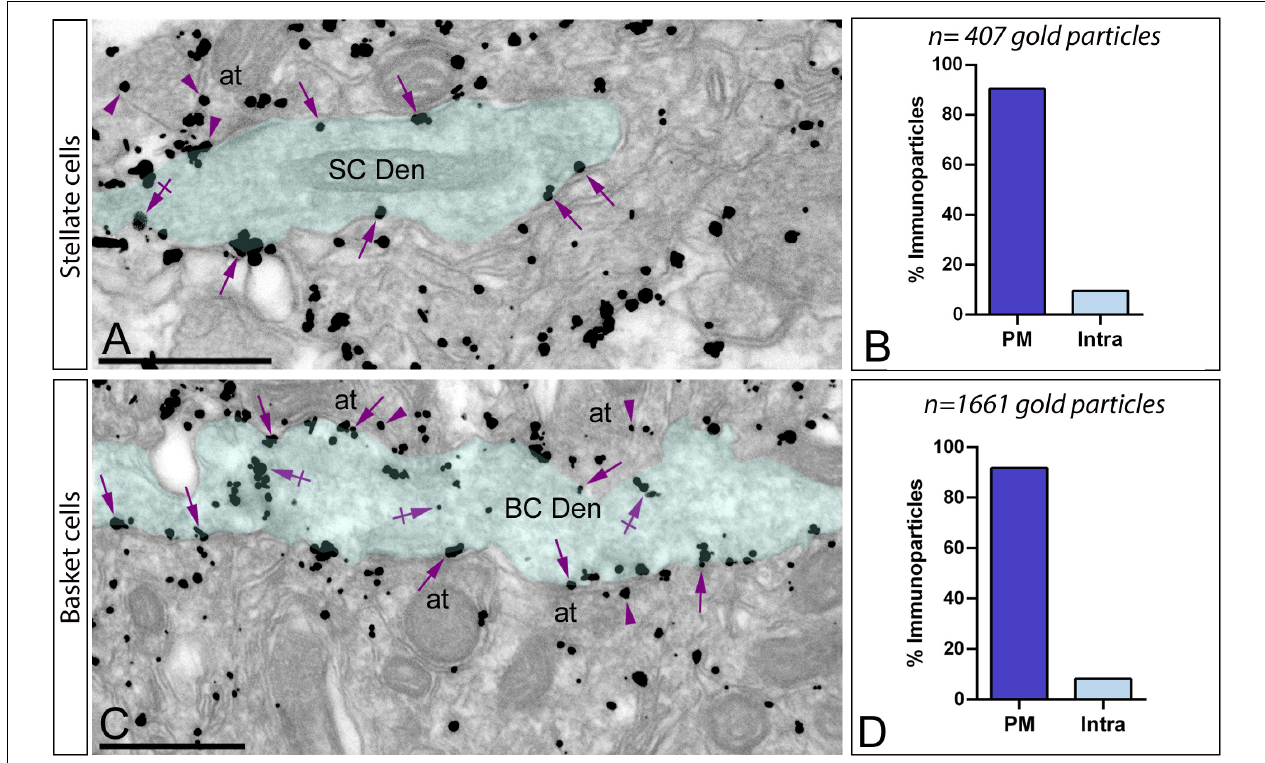
FIGURE 7 | Subcellular localization of G α o in basket and stellate cells. Electron micrographs showing immunoparticles for G α o in the molecular layer of the cerebellum, as detected using a pre-embedding immunogold technique. (A,B) In the outer two-thirds of the molecular layer, immunoparticles for G α o were distributed in smooth dendritic shafts receiving excitatory synapses on their surface, identified as stellate cells (SC Den, green transparent overlay). From a total of 407 G α o immunoparticles analyzed, 90.4% were located along the plasma membrane (PM) (arrows) and only 9.6% at intracellular sites (Intra) (crossed arrows). (C,D) In the inner third of the molecular layer, immunoparticles for G α o were distributed in smooth dendritic shafts receiving excitatory synapses on their surface, identified as basket cells (BC Den, green transparent overlay). From a total of 1.661 G α o immunoparticles analyzed in basket cell dendrites, 91.81% were located along the PM (arrows) and only 8.19% at intracellular sites (Intra) (crossed arrows). Immunoparticles for G α o were also found in axon terminals (arrowheads) (at) establishing excitatory synapses with basket cell dendrites. Scale bars: (A,C) 500